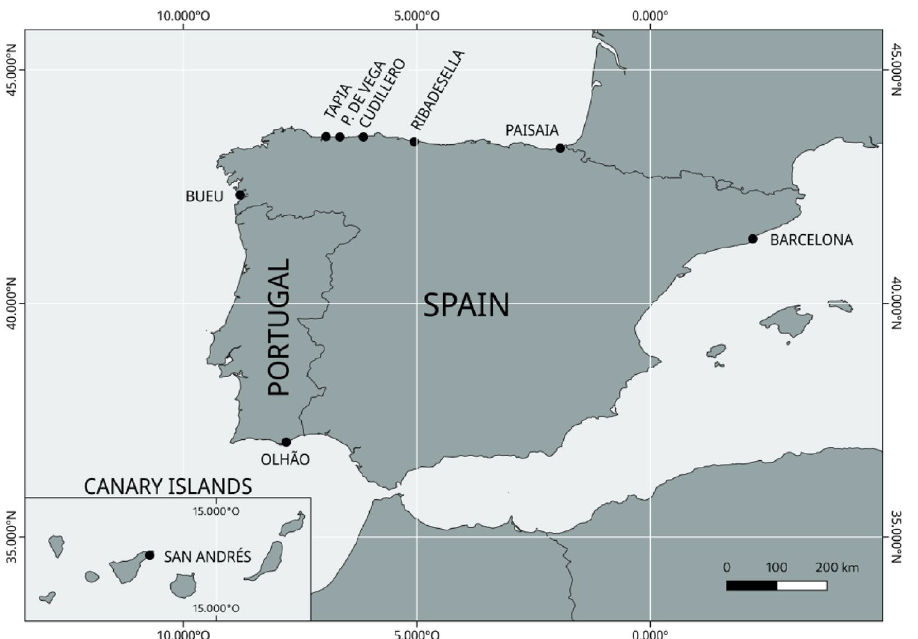
Figure 1. Study regions of the Iberian Peninsula and Canary Islands for genetic analyses of O. vulgaris using microsatellites. A total of 9 localities were sampled (black dots) for population genetic